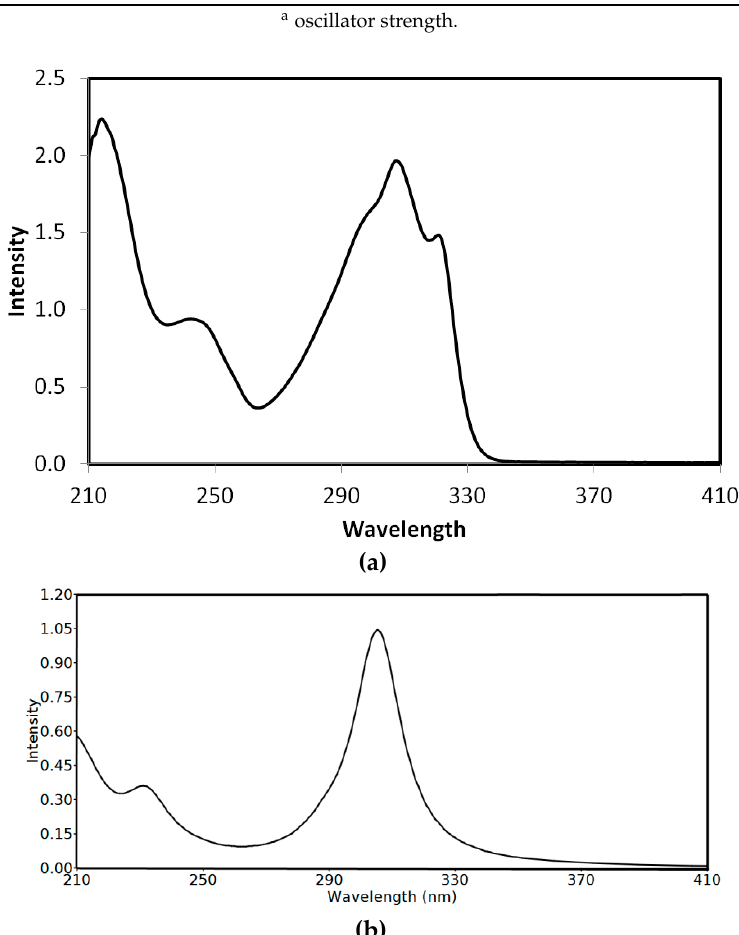
Figure 9. The experimental ( a ) and simulated ( b ) Uv-Vis spectra of 2 using the time-dependant density functional theory (TD-DFT) method.